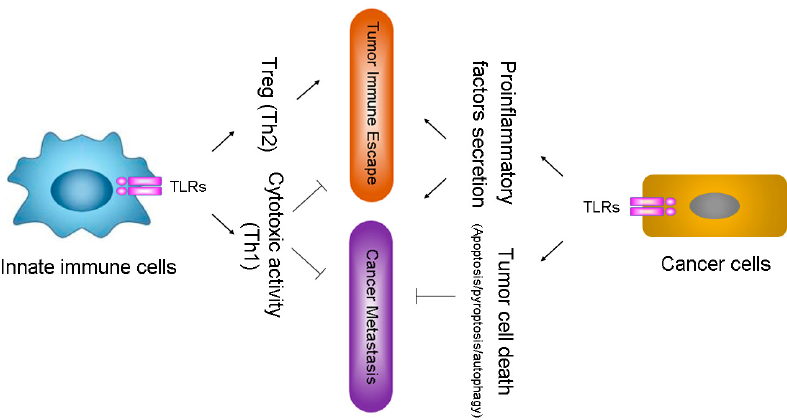
Figure 2. Toll-like receptors (TLRs) and cancer. TLRs activation in innate immune cells, such as dendritic cells (DCs) and macrophages, and tumor cells lead to a complex cascade reaction, which determines the role of TLRs in cancer development. The activation of TLRs in innate immune cells lead to either T cytotoxic responses (Th1) or regulatory T cell (Treg) responses (Th2). The activation of certain TLRs, such as TLR2, 4, and 9, in cancer cells promotes tumor immune escape and cancer metastasis by increasing the secretion of pro-inflammatory factors, while the activation of TLR3, 4, 5, and 7 might inhibit cancer via inducing cell death (including apoptosis, pyroptosis, and autophagic cell death) of cancer cells.